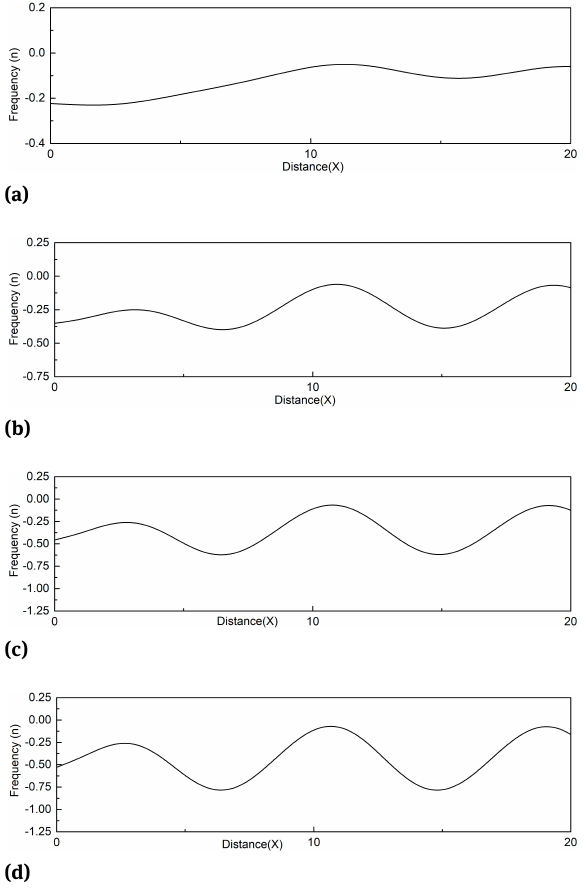
Fig. 7: Comparison between full numerical wave number of ˆ (cid:96) = 0.75 and the Bond number B = 0.01, 0.02, 0.03, 0.04 with fixed values of M −6 and β = 2 . ( from top to 0 = 0.3, β 1 = 3.3 × 10